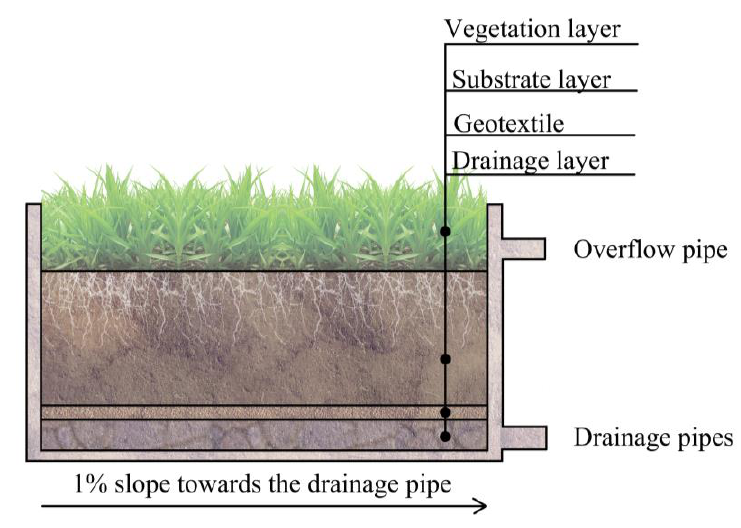
Figure 1. Schematic diagram of the extensive green roof module used this study.